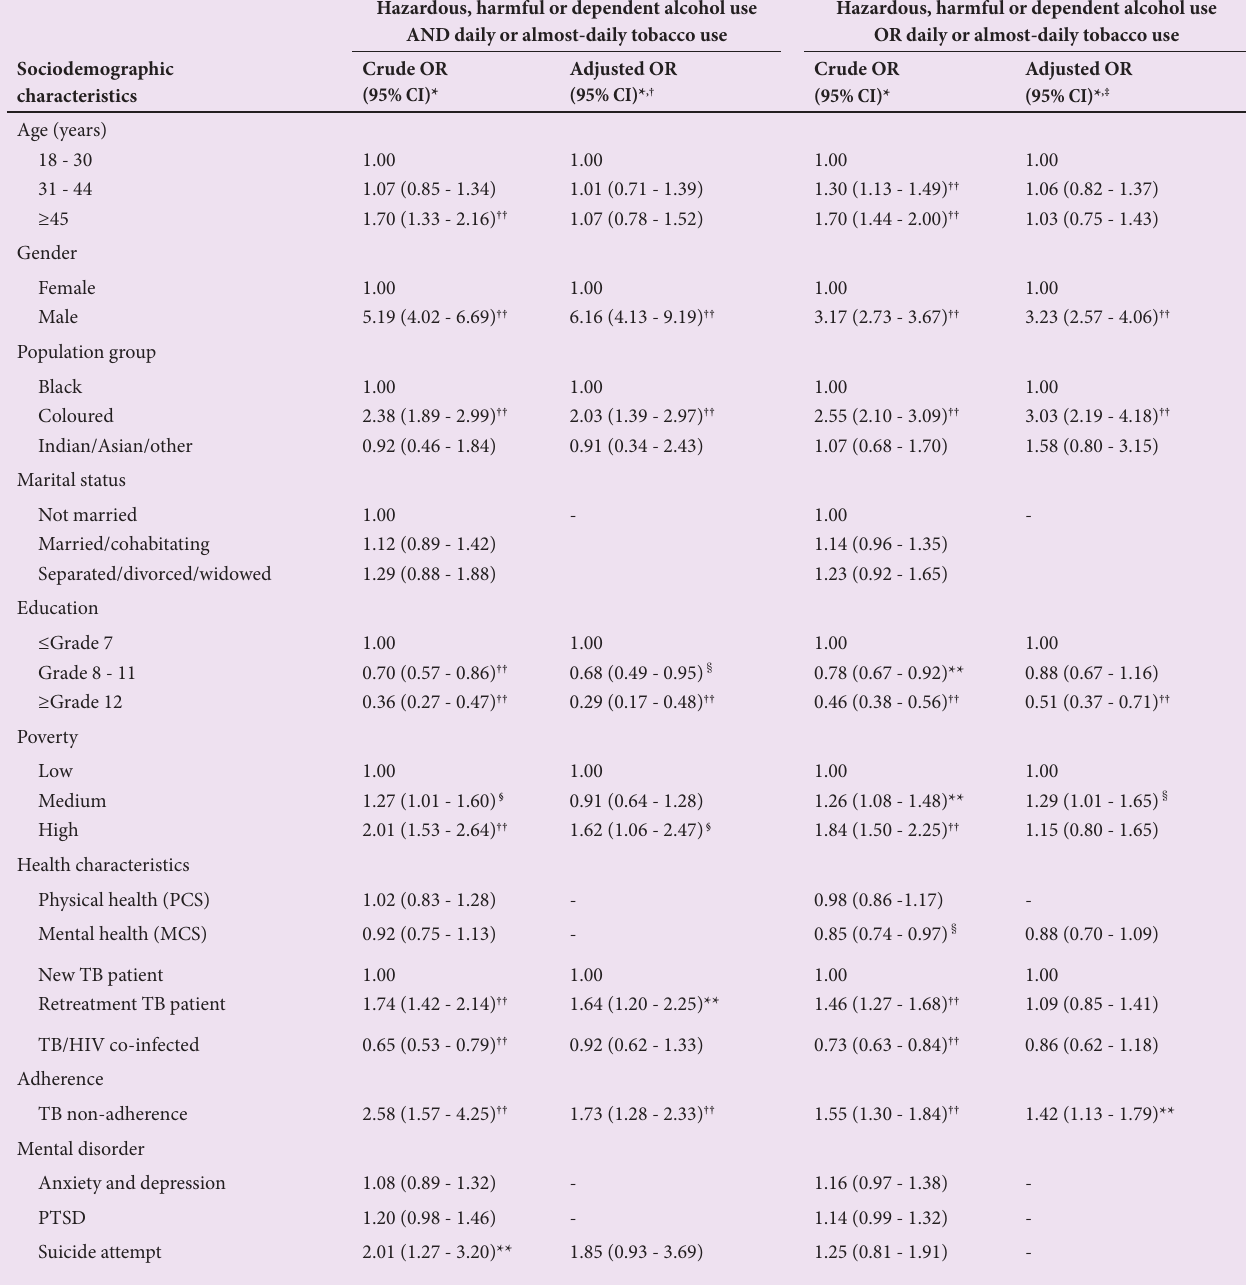
Table 3. Association of socioeconomic and clinical characteristics, mental ill-health and alcohol and tobacco use among TB patients